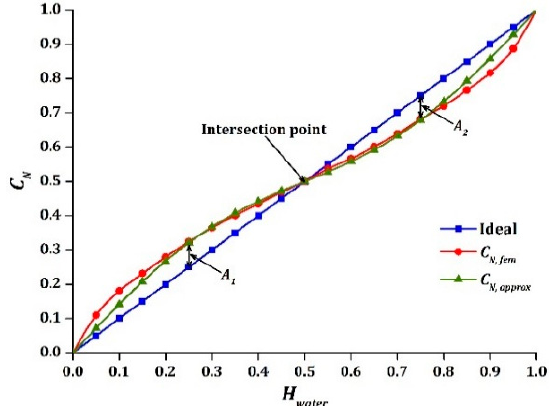
Figure 4. C N , fem and C N , approx versus H water . Figure 4. (cid:1829) (cid:3015),(cid:3033)(cid:3032)(cid:3040) and (cid:1829) (cid:3015),(cid:3028)(cid:3043)(cid:3043)(cid:3045)(cid:3042)(cid:3051) versus (cid:1834) (cid:3050)(cid:3028)(cid:3047)(cid:3032)(cid:3045) .